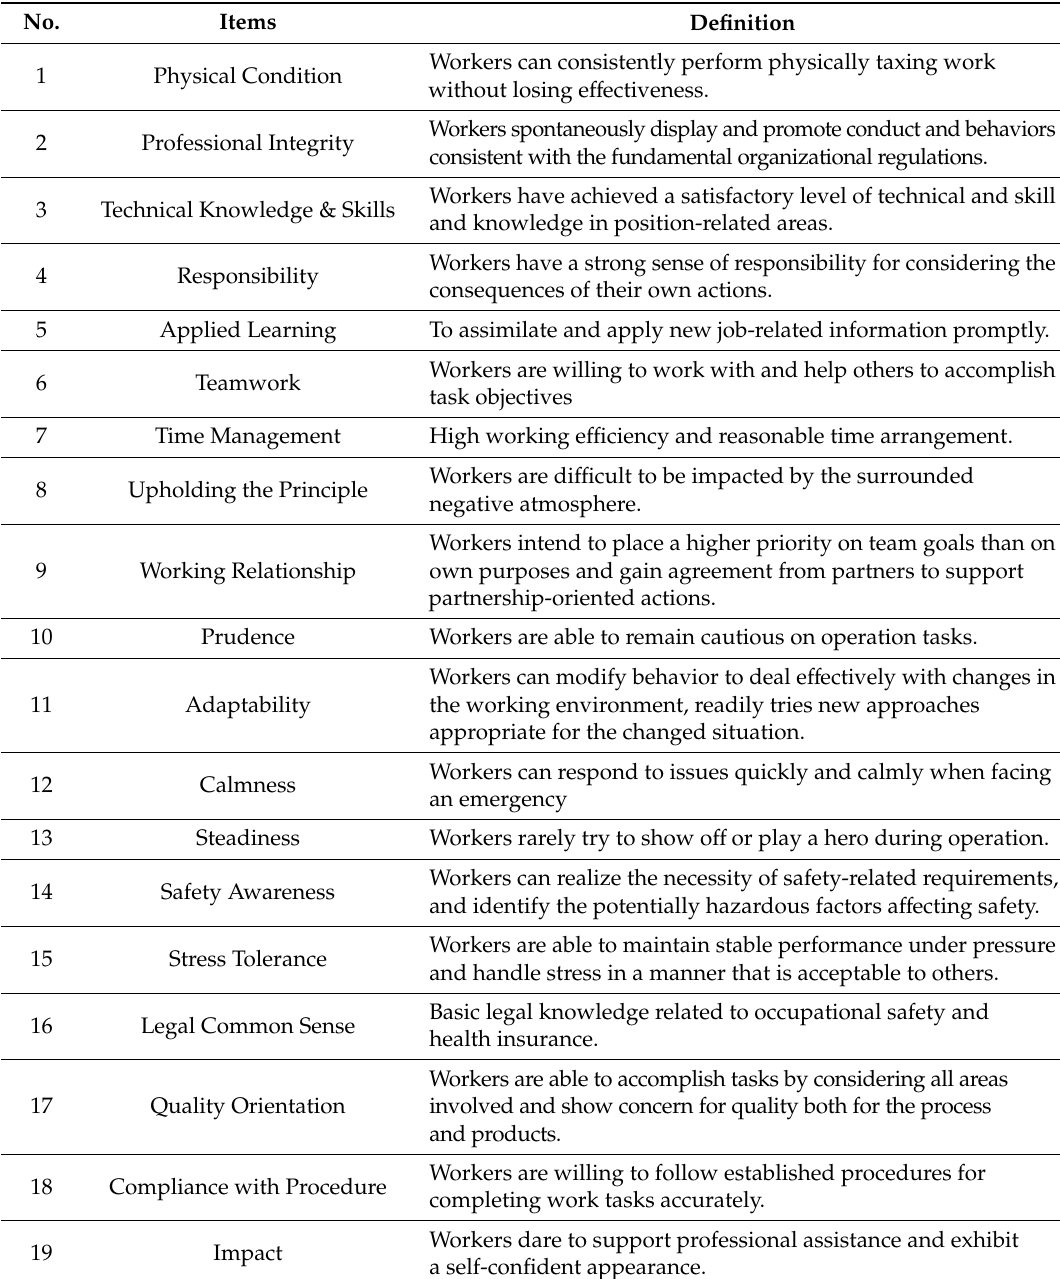
Table 3. Definitions of items included in the